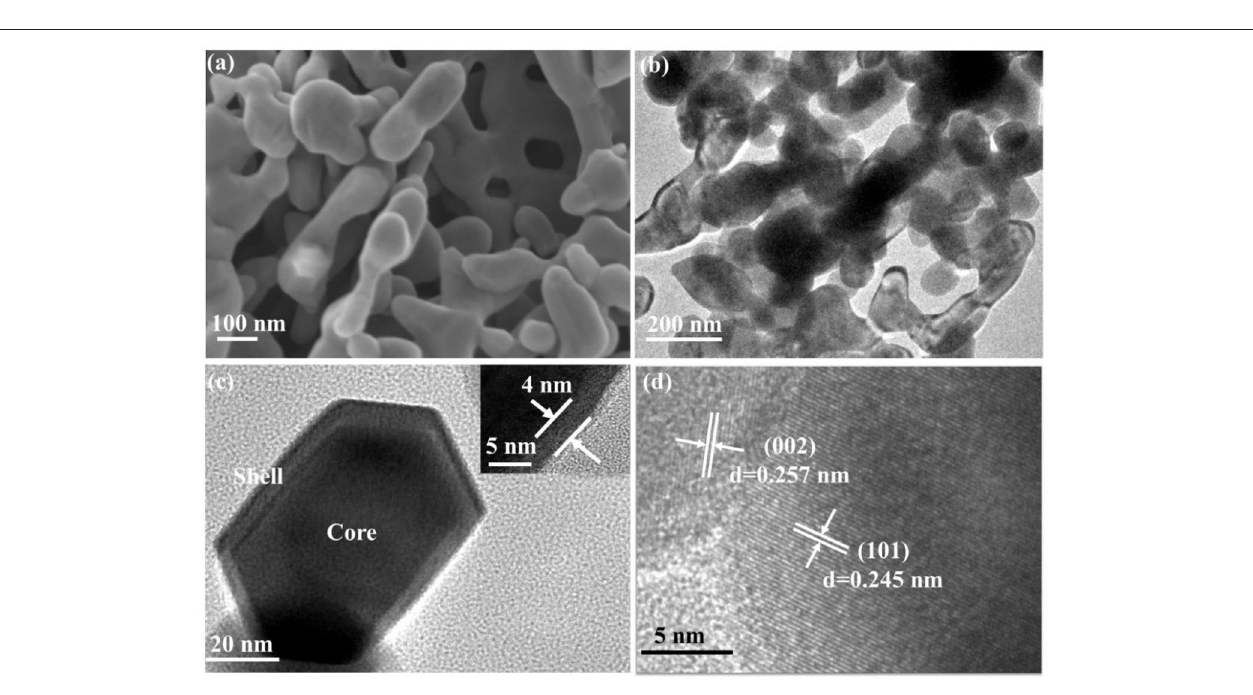
FIGURE 2 | (a) SEM; (b,c) TEM (Inset was the shell thickness); (d) HR-TEM of porous ZnO calcined under 550 ◦